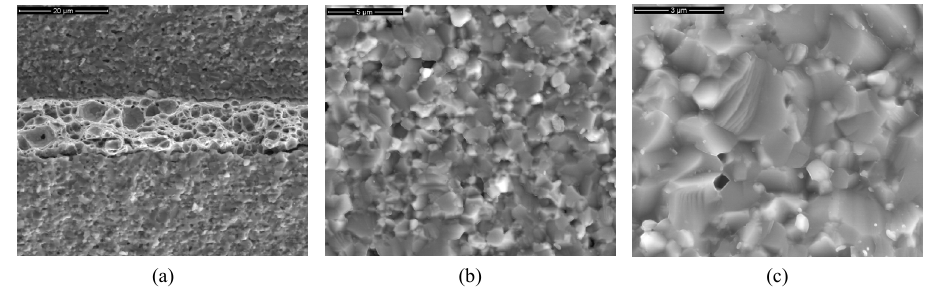
Fig. 6 SEM images of fractured cross-section of the multilayer varistor with 0.5 wt% of AlF 3 –CaB 4 O 7 addition, sintered at 920 ℃ : (a) 3000×, (b) 10000×, (c) 20000×.